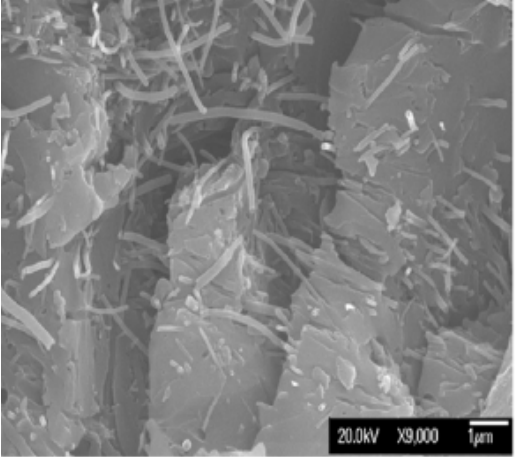
Figure 8. FESEM micrographs of fracture surfaces in 1.0 wt % O-CNFs incorporated composites showing nanofibers impregnation and bridging with epoxy [40] .